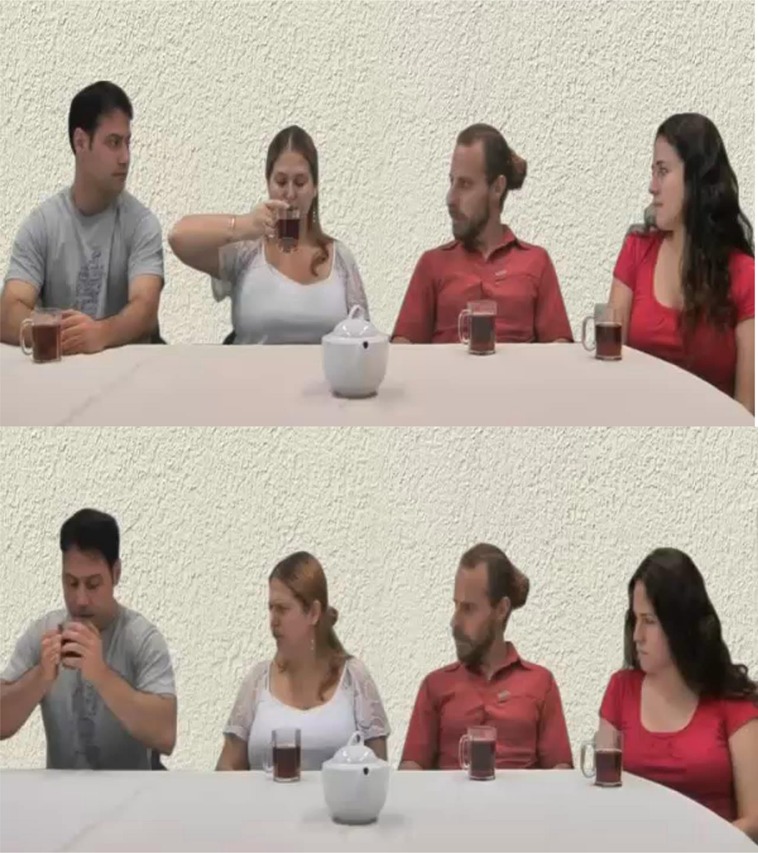
Example stimulus.